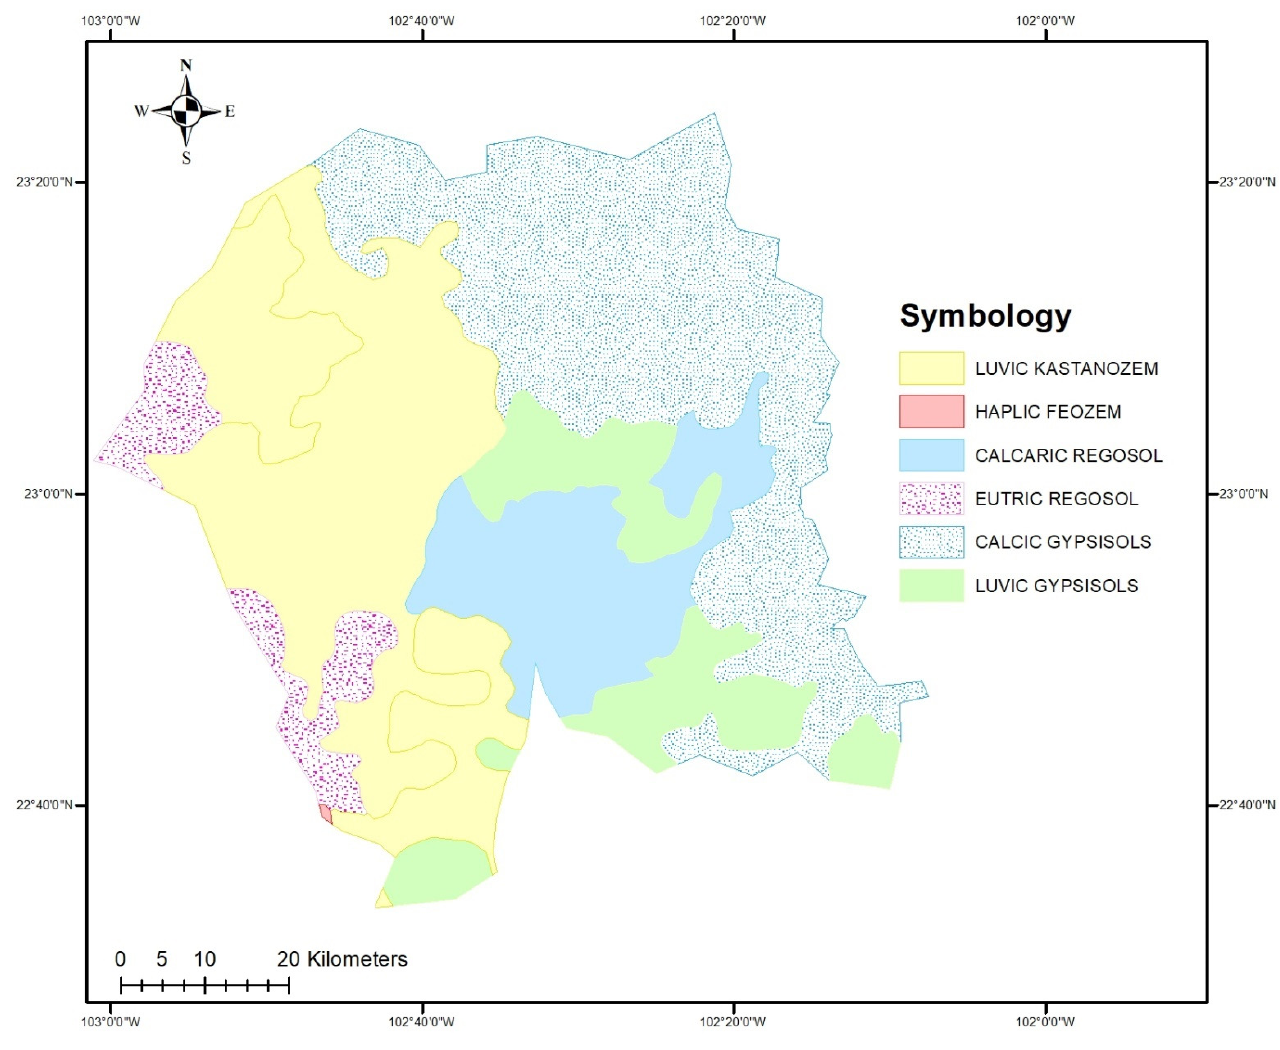
Figure 2. Edaphology of the study